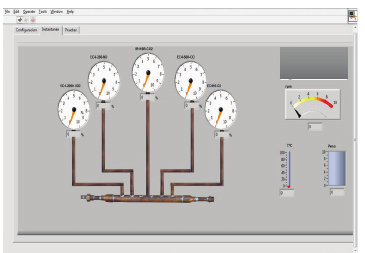
Figure 18: Graphical user interface, instant tab.